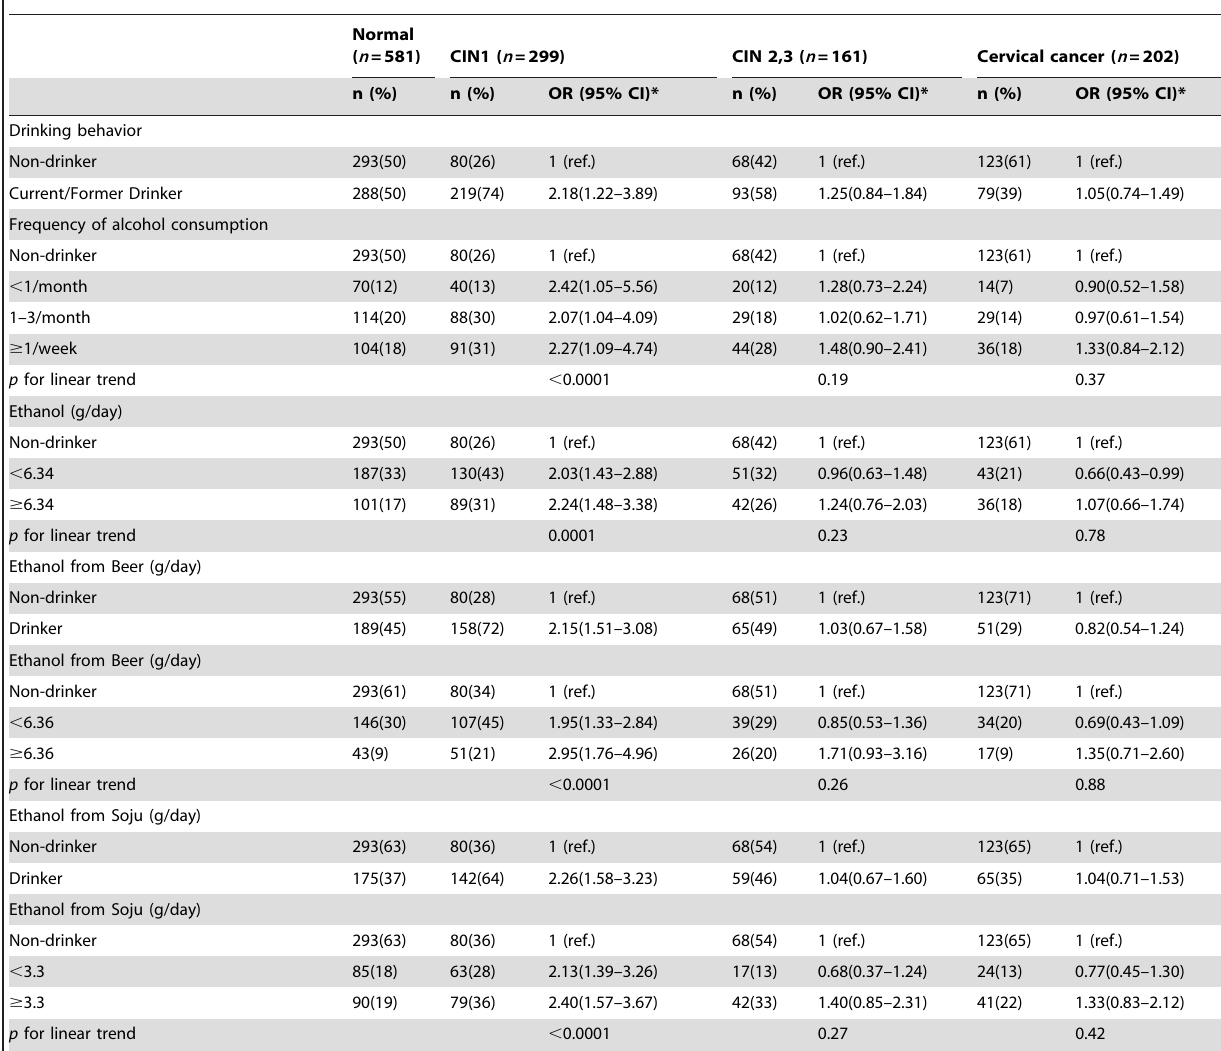
Table 2. Association between alcohol drinking and cervical dysplasia and